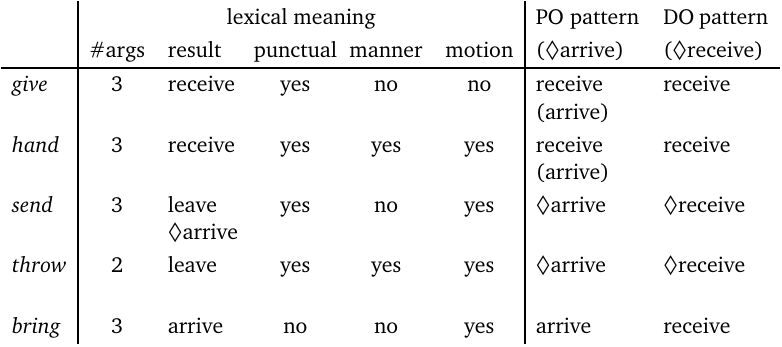
Semantic classes of verbs in interaction with the DO and PO